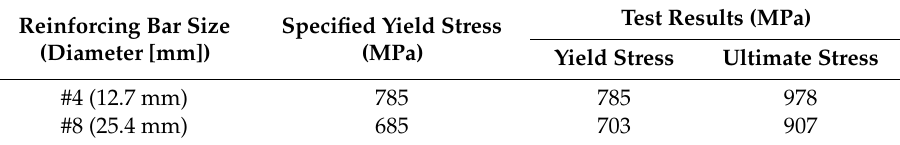
Table 5. Tensile test results for reinforcing bars.